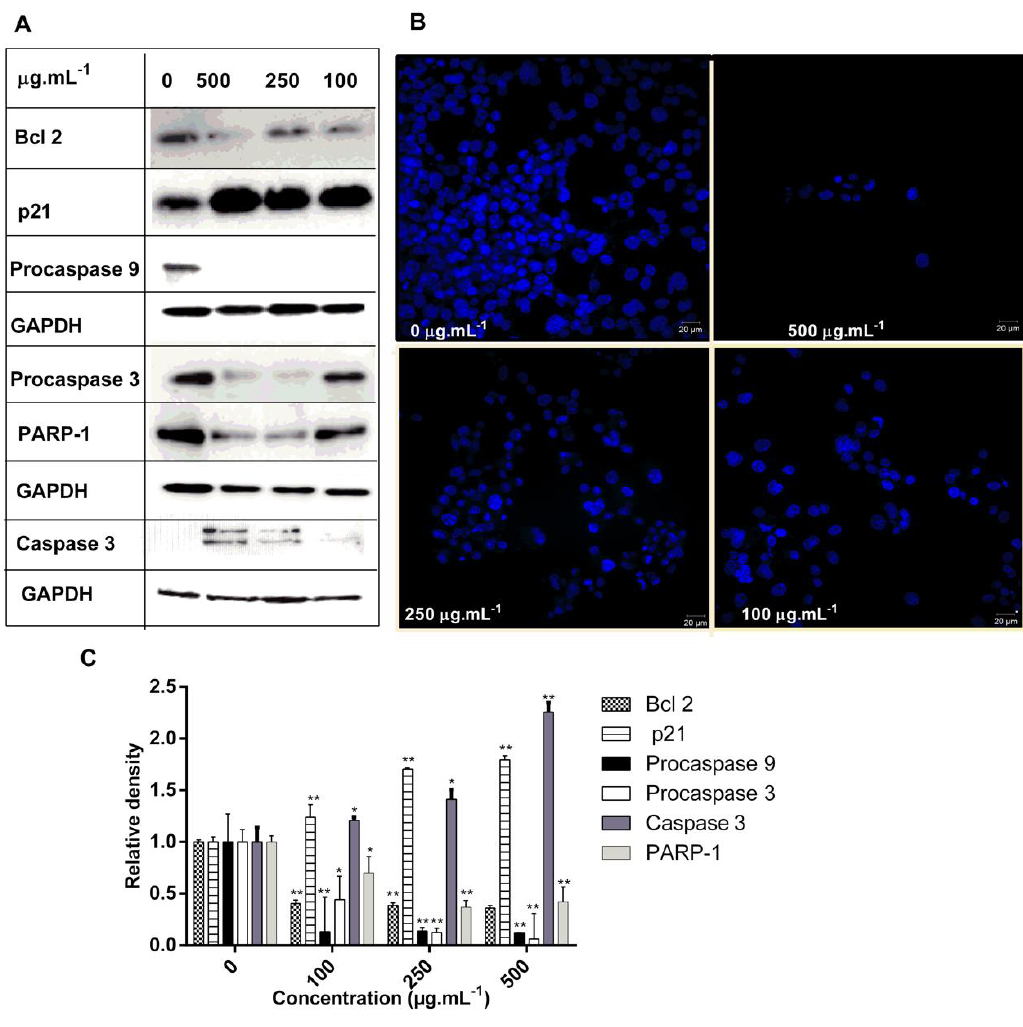
Figure 6. DM soxlet promotes apoptosis in colon carcinoma cells: ( A ) Representative Western blot analysis showing a significant increase of p21 and decrease in the levels of Bcl 2, procaspases, and PARP-1, along with caspase 3 activation. Expression of GAPDH was used as an internal control; ( B ) DAPI micrographs of HCT-116 cells treated with DM soxhlet extract at different concentrations (500, 250, 100, and 0 µg·mL −1 ). Nuclei were counterstained with DAPI (blue) at 40X magnification Scale bars =20 μm ; ( C) Quantification of the western blots using image J analysis * p < 0.05 and ** p < 0.01.